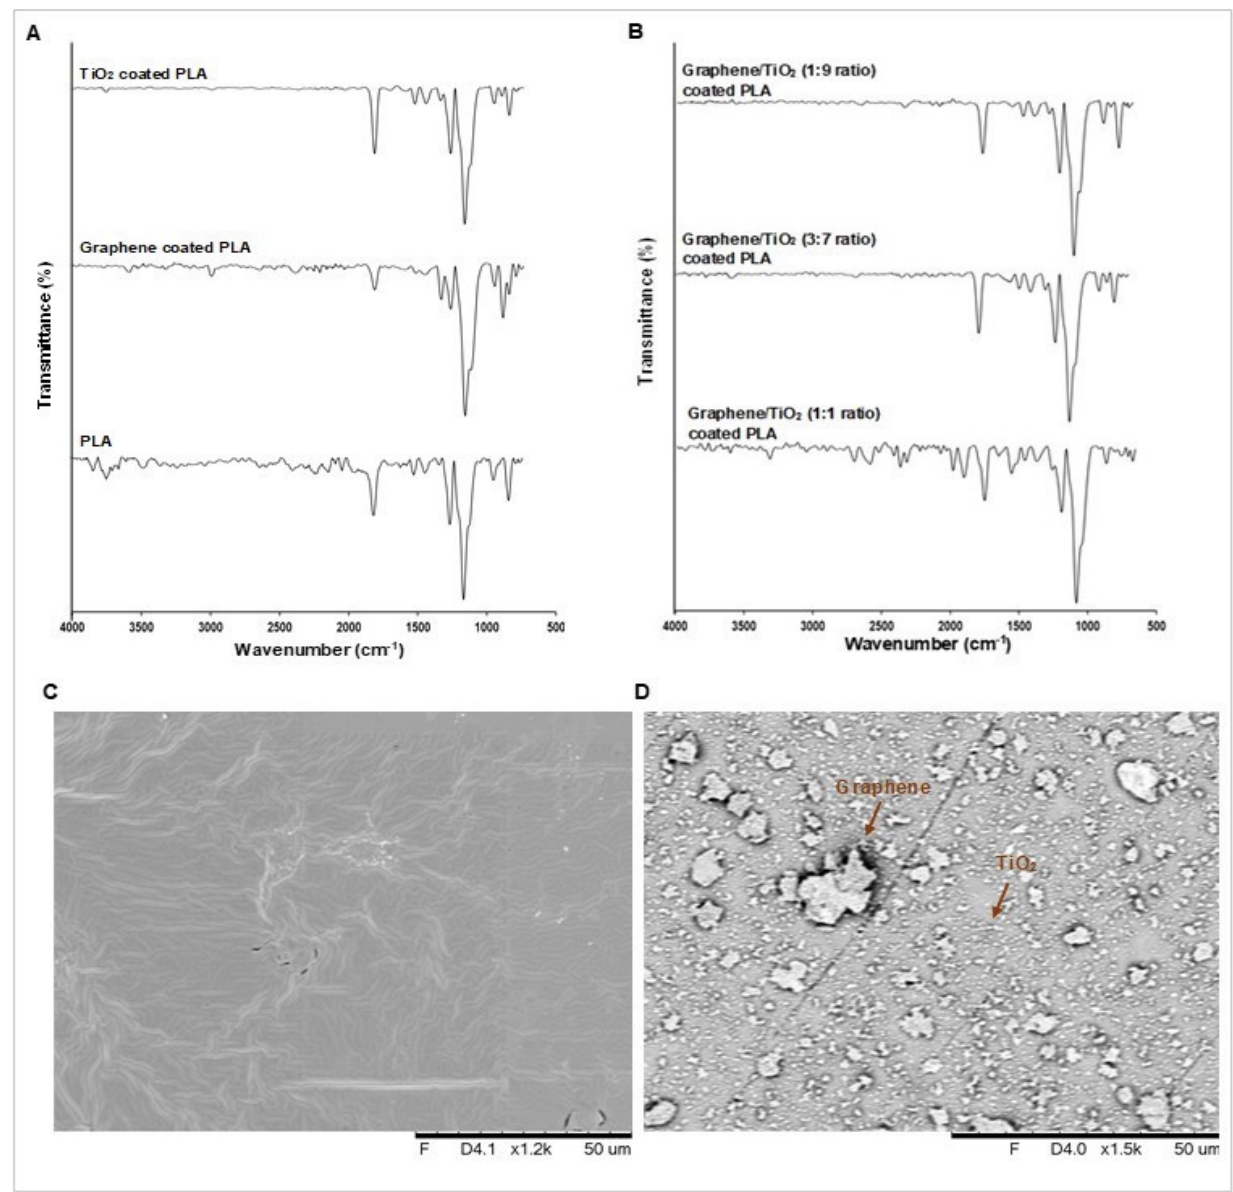
Figure 4. FTIR spectra of ( A ) the PLA film without coating, the graphene-coated film, and the TiO 2 -coated film, and ( B ) the graphene/TiO 2 -coated film. SEM images of ( C ) the PLA film and ( D ) the graphene/TiO 2 -coated PLA film.